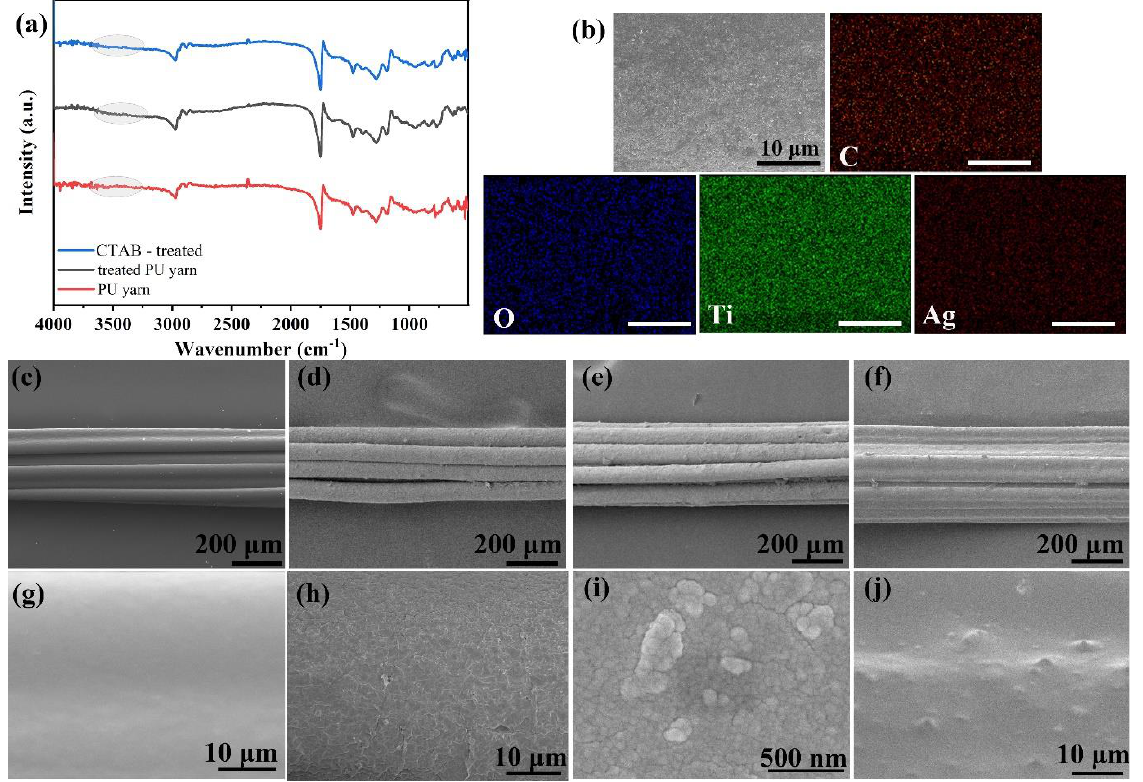
Figure 2. ( a ) FTIR of treated yarns, ( b ) EDX mapping of Ag/MXene/PU yarn (scale bar: 10 μm), ( c ) and ( g ) SEM images of pure PU yarn, ( d ) and ( h ) MXene/PU yarn, ( e ) and ( i ) Ag/MXene/PU yarn, ( f ) and ( j ) PDMS/Ag/MXene/PU yarn.